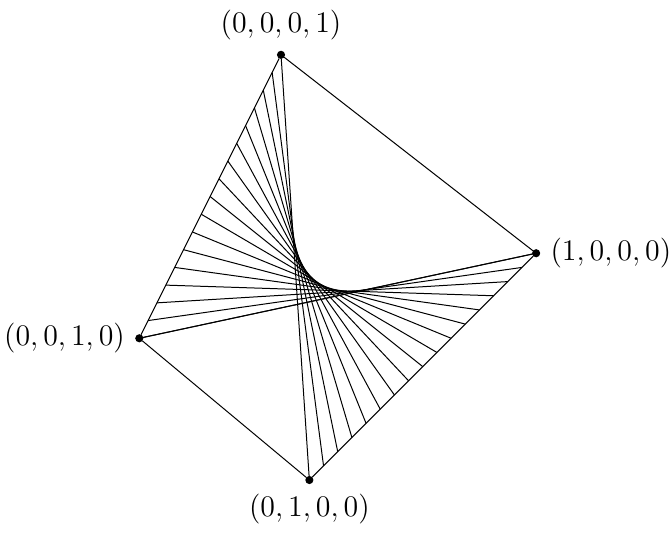
Figure 1: Probability simplex for binary X and Y where their jpd P = ( p , p , p , p ) is a point in it. Any jpd on surface shown by lines represents 00 10 01 11 independence of X and